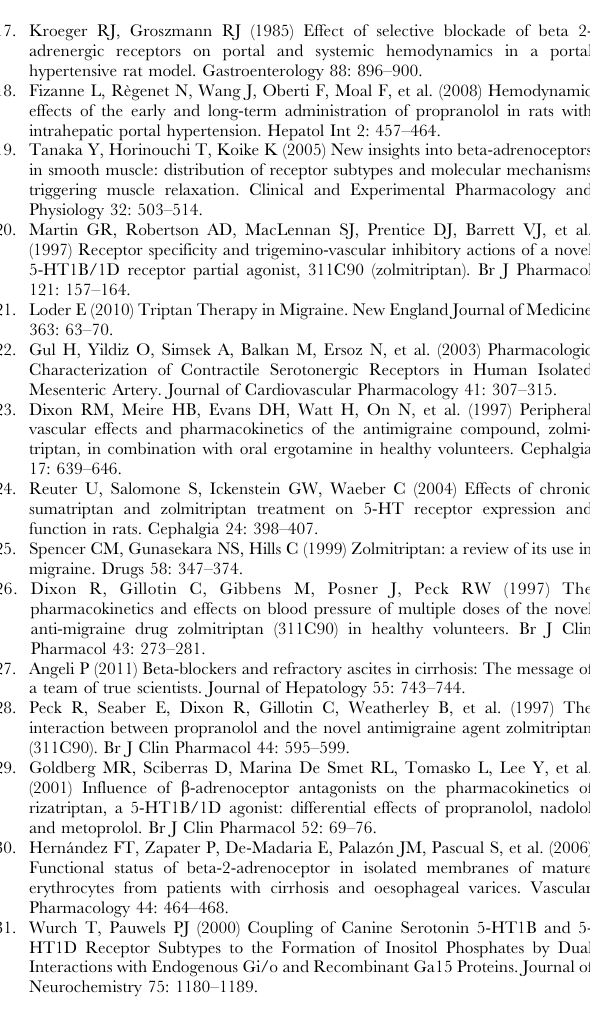
Figure S2 Effect of zolmitriptan in PVP (A), ARF (B), HF (C) and MAP (D) in CCl4-treated rats (N = 5 per group). Zolmitriptan (20 mg/kg) was administered through the femoral vein catheter as an infusion (20 min). Values are presented as mean 6 SEM. */**p , 0.05/0.01 vs saline. PVP: portal venous pressure, ARF: arterial renal flow, HF: heart frequency, MAP: mean arterial pressure. Figure S3 Levels of norepinephrine in the spleen (A) and duodenum (B) of CCl4-treated rats subjected to either sham or splanchnic sympathectomy (SS). *p , 0.05 vs sham. Table S1 Body weight, biochemical data and basal hemodynamic parameters of rats with portal hyperten- sion which received i.v. infusion of beta-blockers or saline alone or beta-blockers followed by zolmitriptan. Body weight and biochemical parameters are expressed as median and ranges. Hemodynamic data are expressed as mean 6